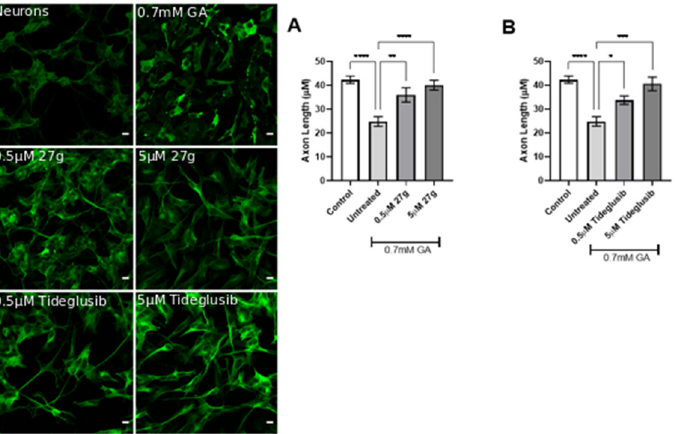
Figure 10. Dose-dependent amelioration of neurite morphology by compound 27g in 0.7 mM GA- exposed neurons. ( A ) Neurite length quantification of 0.7 mM GA-treated SH-SY5Y-differentiated neurons after 27g treatment. Scale bar 100 μ M. ( B ) Neurite length quantification of 0.7 mM GA-